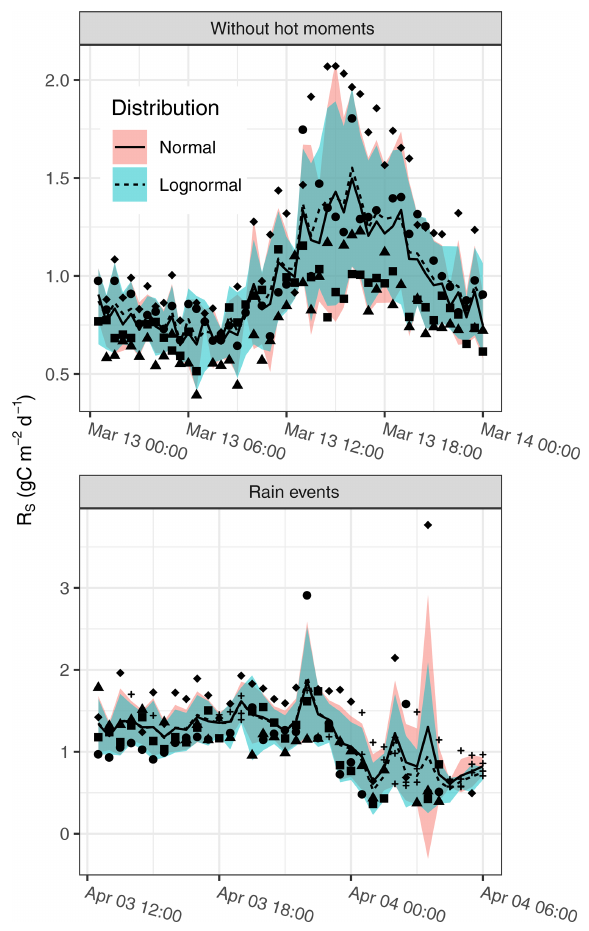
Figure 3. Observed fluxes for neighboring chambers (symbols) and aggregated across chambers: expected values (lines) and 95% pre- diction interval bounds (shaded areas). Crosses denote gap-filled values. The lognormal approach avoided negative lower prediction interval bounds with hot moments, for example with rain events on 4 April.